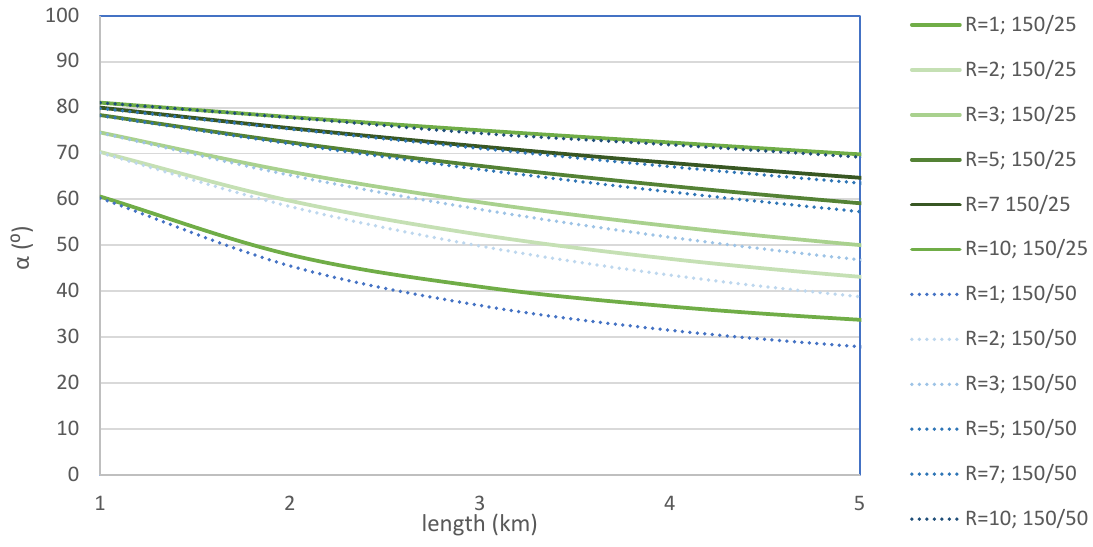
Figure 12. α for faults in overhead section of mixed feeder (cable in a trefoil configuration).